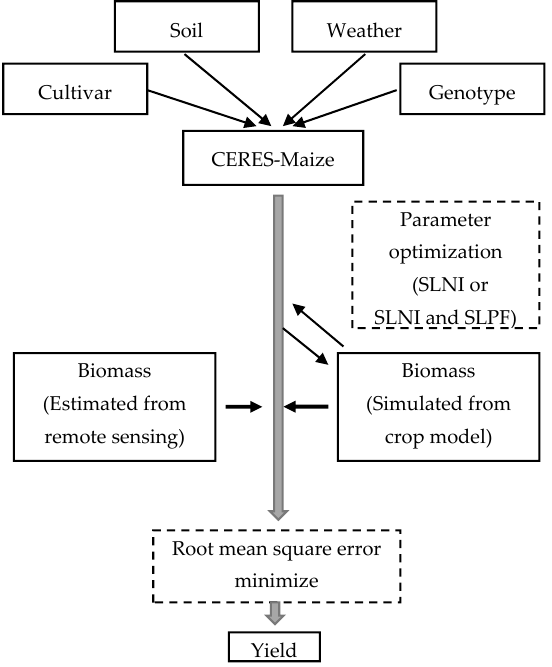
Figure 2. Flow chart of using biomass data estimated from satellite imagery into the CERES-Maize model for spatial optimization of total soil nitrogen concentration (SLNI) or SLNI and soil fertility factor (SLPF) (boxes in solid lines indicate inputs and outputs and boxes in dashed lines indicate optimization process).